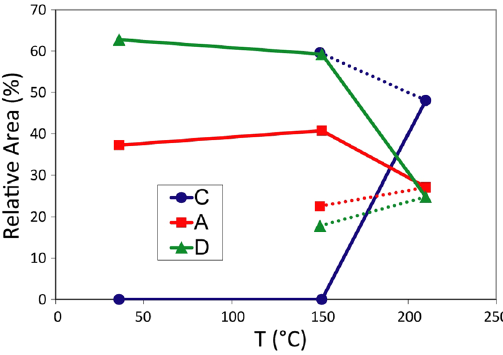
Figure 4. Evolution of spectral areas in the eMS spectra of GeTe-2 as a function of the